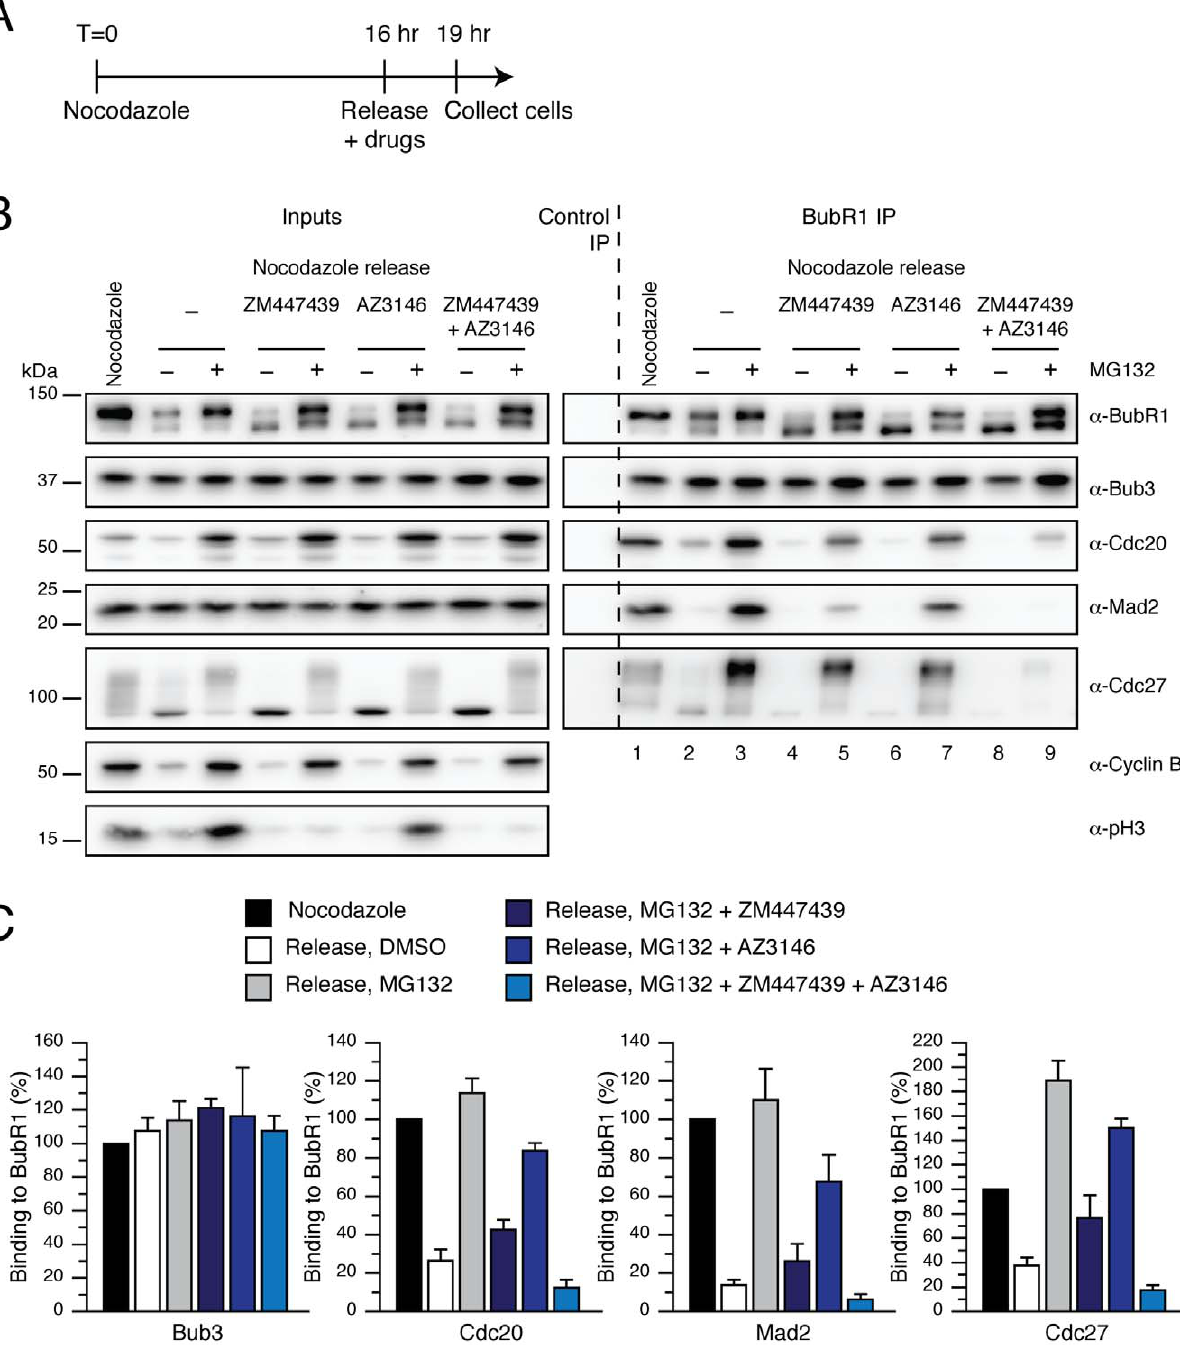
Figure 5. Proteasome activity is not required for MCC disassembly. ( A ) Timeline showing the experimental strategy. ( B ) Immunoblot of BubR1 immune complexes isolated from HeLa cells arrested in mitosis with nocodazole and released into media containing different combinations of MG132, ZM447439 and AZ3146. Cyclin B and phosphorylated histone H3 Ser10 (pH3) were used as markers for mitosis and Aurora B activity respectively. ( C ) Bar graph quantifying the experiment in (B). Values represent the mean 6 s.e.m. of three independent experiments.